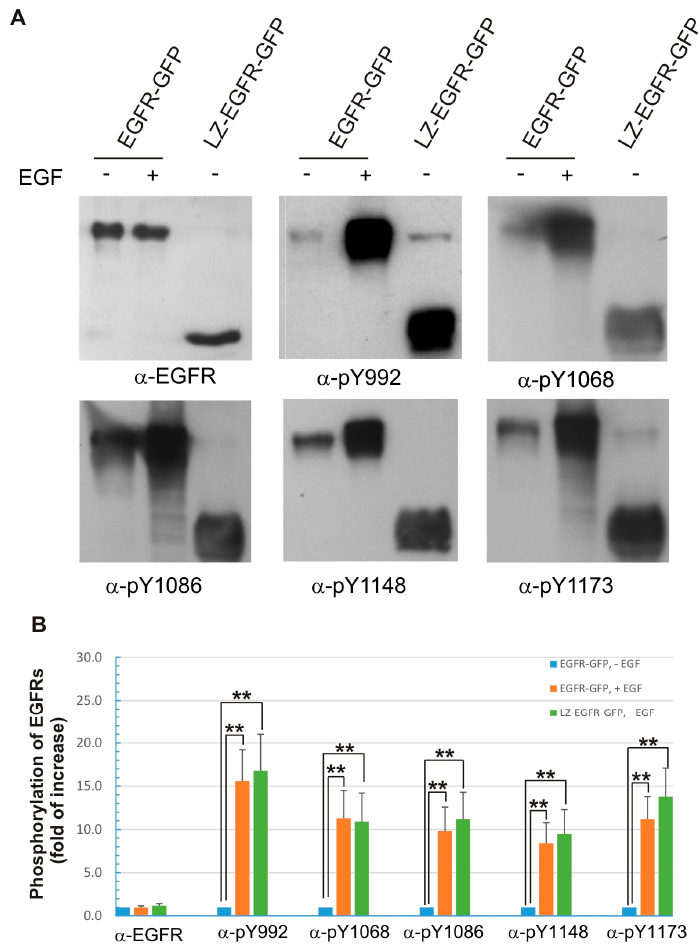
Figure 6. Phosphorylation of the five major C-terminal tyrosine residues of EGFR-GFP and LZ-EGFR-GFP. ( A ) 293T cells were transiently transfected with EGFR-GFP or LZ-EGFR-GFP. Following serum starvation for 24 h, cells were treated with or without EGF. The cell lysates were subjected to immunoblotting analysis with rabbit anti-pEGFR (pY992), anti-pEGFR (pY1068), anti-pEGFR (pY1086), anti-pEGFR (pY1148) and anti-pEGFR (pY1173) antibodies; ( B ) Quantification of the data from ( A ). The band is quantitated by densitometry with image J software. The phosphorylation level of the control (EGFR-GFP, without EGF treatment) was set to 1 and the phosphorylation of the receptors under other conditions was expressed as the fold increase compared to control. Each value is the average of at least three independent experiments and the error bar is the standard error. **: p < 0.01.